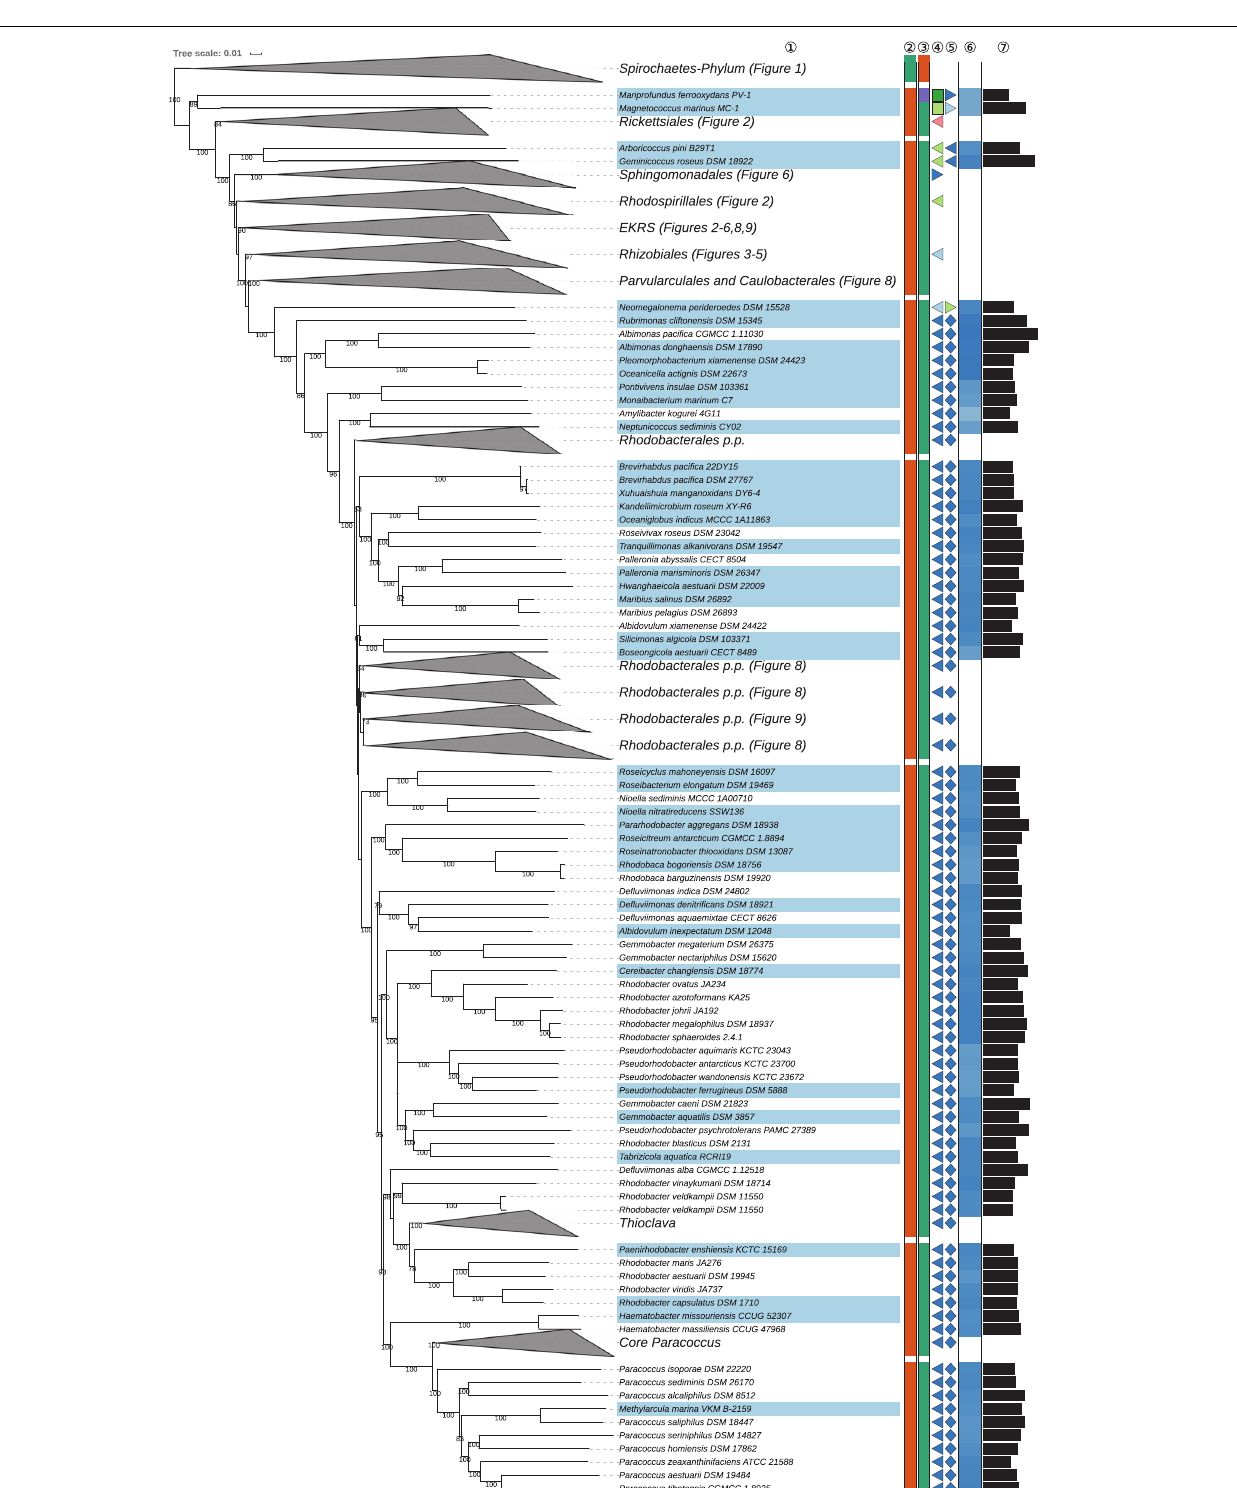
Frontiers in Microbiology |